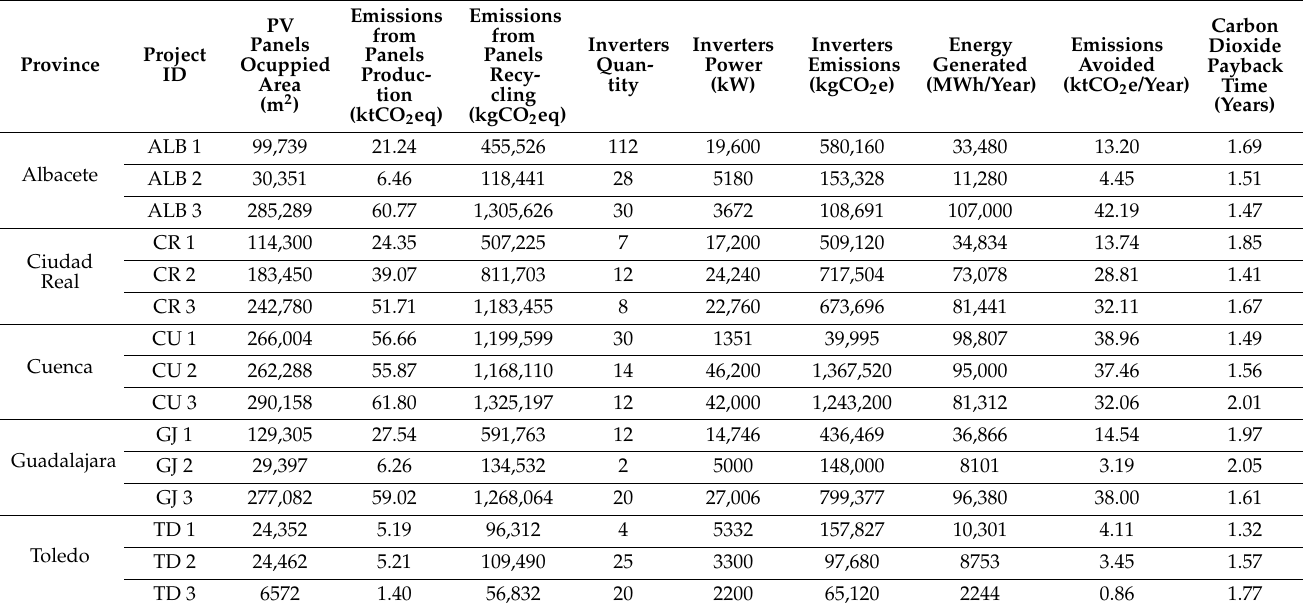
Table A2. Data and calculation for the Carbon-dioxide Payback Time (CPBT) of the 15 selected PV centrals in the Castilla-La Mancha region.